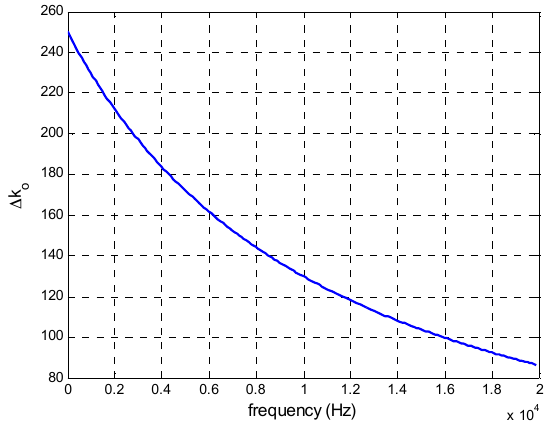
Figure 8. Variation in the gain factor due to a temperature difference of 5 °C with respect to signal frequency.